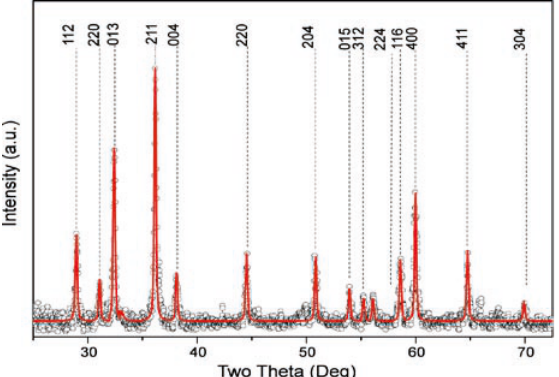
Figure 1. XRD pattern of the Mn